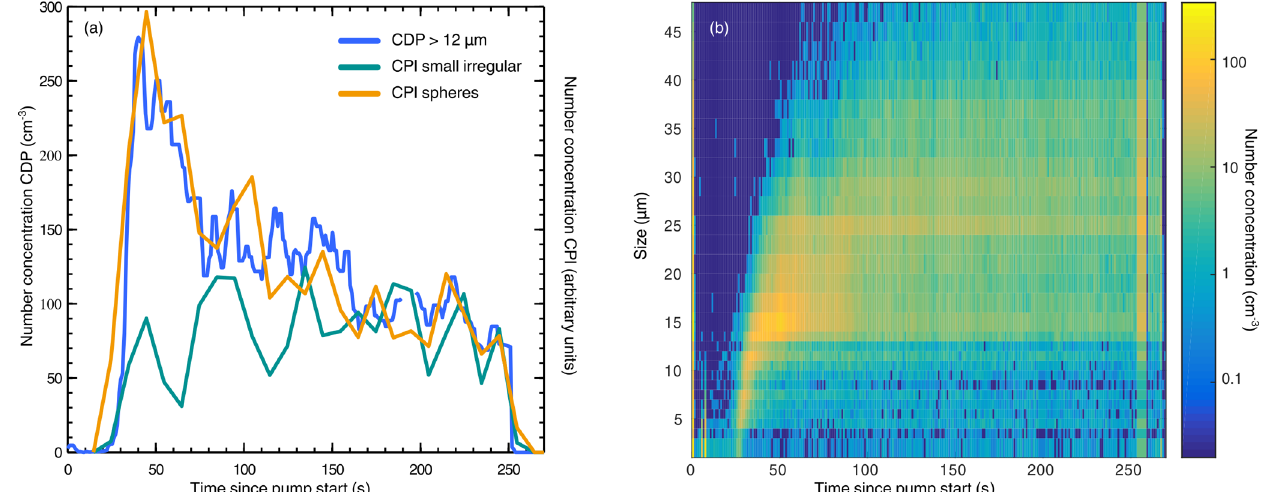
Figure 1. (a) Measurements from the CPI instrument for the two particle habit classifications observed: small irregular (ice), green line; and spheres (drops), orange line. The CDP for particles with sizes greater than 12µm is represented by a blue line. CPI data is shown without units because the data is qualitative. (b) Size distribution of cloud particles measured by the CDP in MICC during an expansion